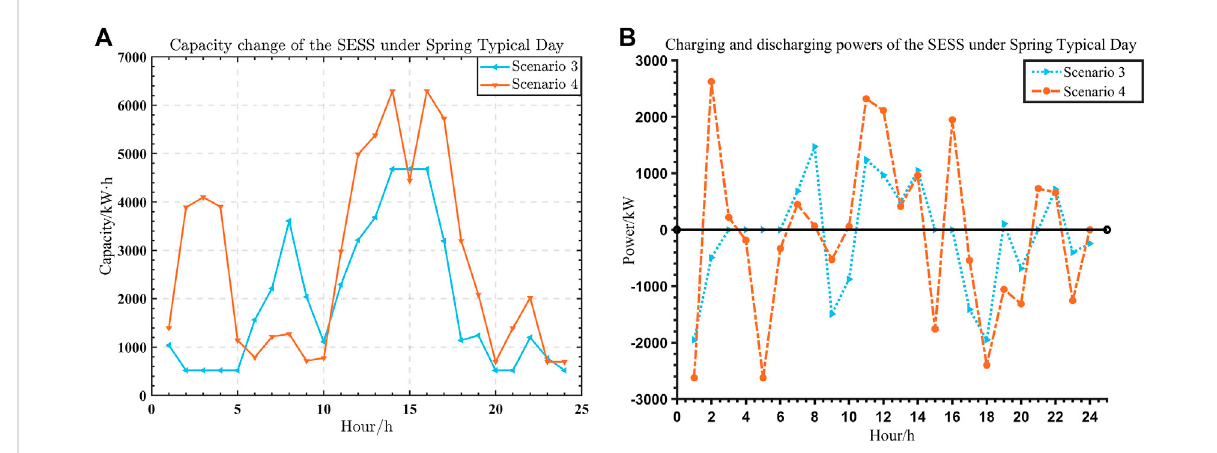
FIGURE 7 Comparison of the capacity change and charging and discharging power of the SESS under Spring Typical Day between scenarios 3 and 4: (A) capacity change; (B) charging and discharging power.